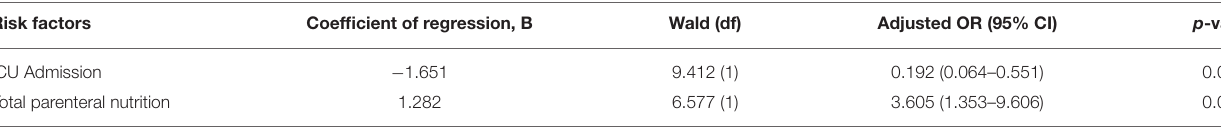
TABLE 4 | Multivariate analysis of C. parapsilosis CRBSI risk